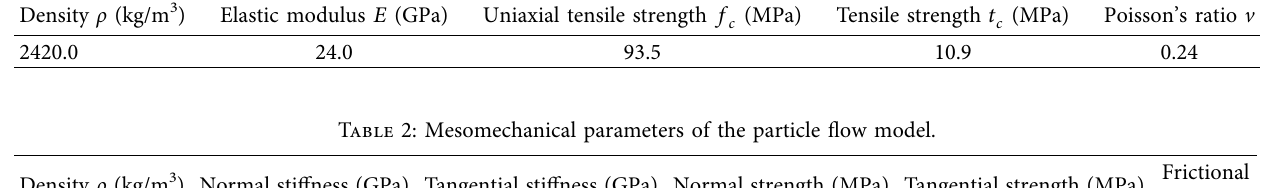
Table 1: Macroscopic physical and mechanical parameters of rock materials.